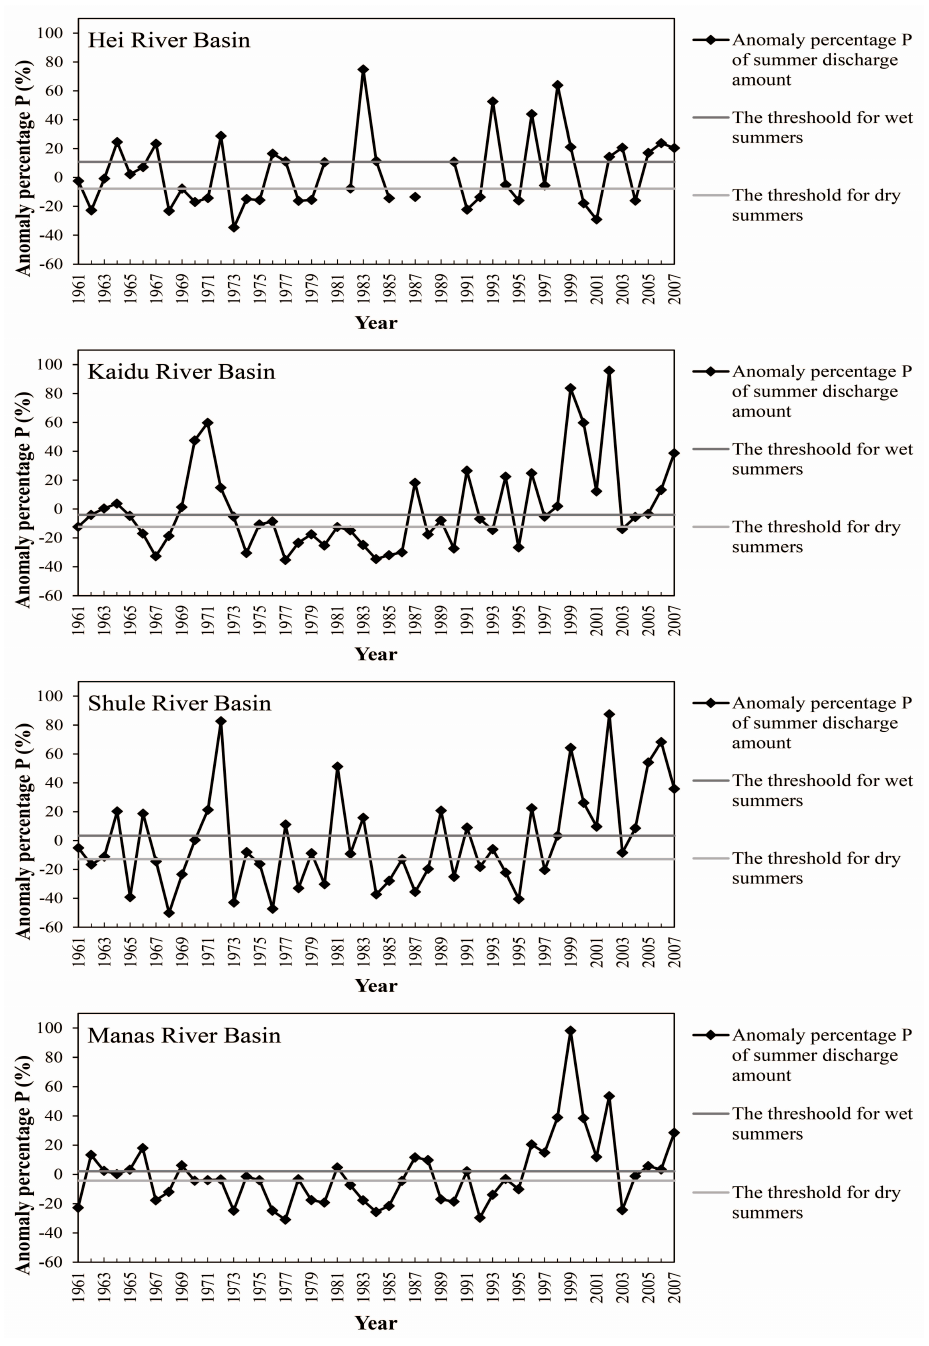
Figure 3. The anomaly percentage P of summer discharge amount in studied basins and the thresholds for wet and dry summers of these basins.